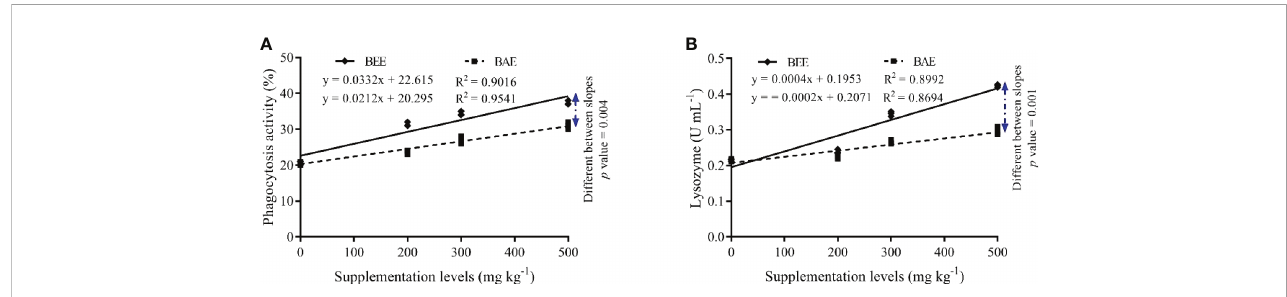
FIGURE 2 The fi t regression model and slope differences between dietary supplementation of basil ethanol (BEE) and aqueous extracts (BAE) on phagocytosis activity (A) and lysozyme activity (B) of Nile tilapia, Oreochromis niloticus .